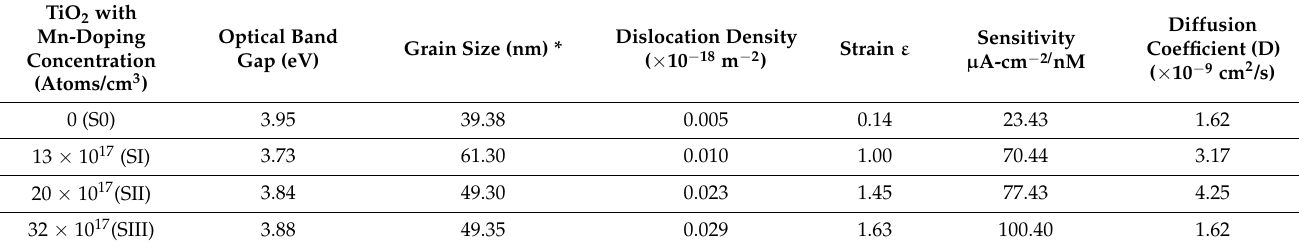
Table 1. Materials and sensing properties of the fabricated sensors based on Mn-doped TiO 2 nanoparticles. TiO 2 with Mn-Doping Concentration (Atoms/cm 3